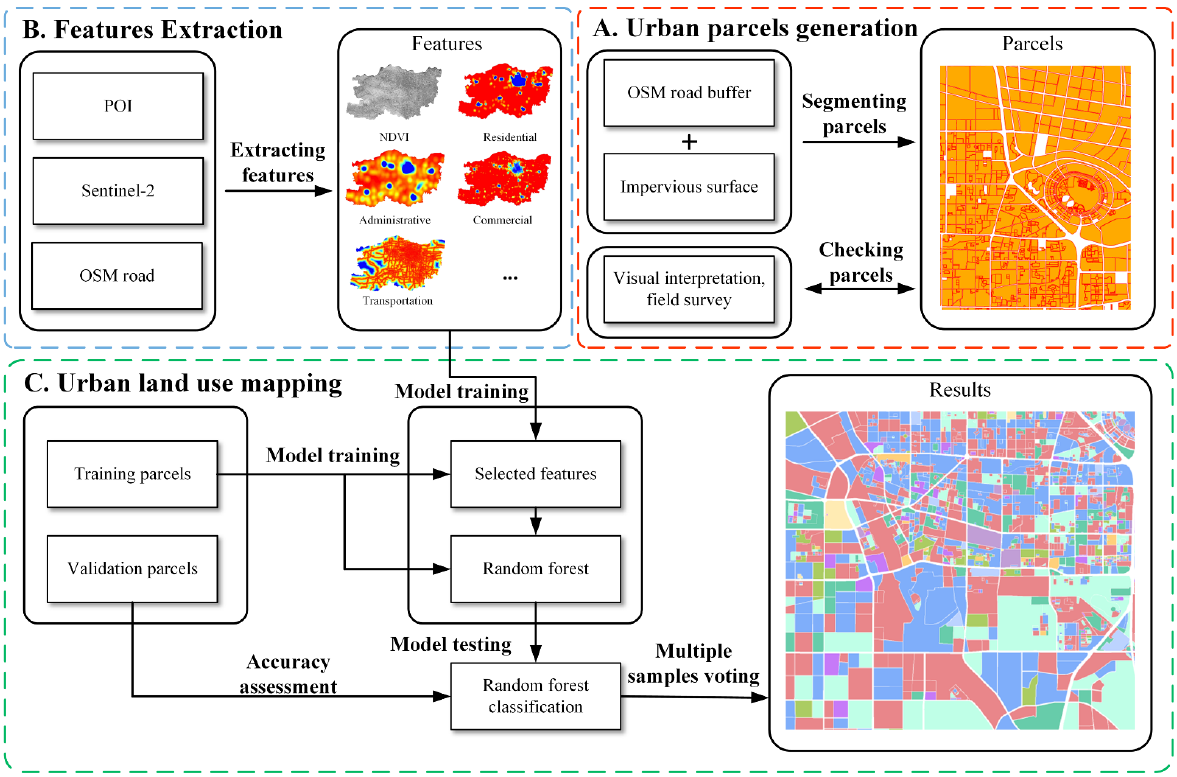
Figure 3. Main flowchart: ( a ) urban sample plot production; ( b ) multisource data feature extraction; ( c ) urban land-use map generation using random forests and multisample voting.